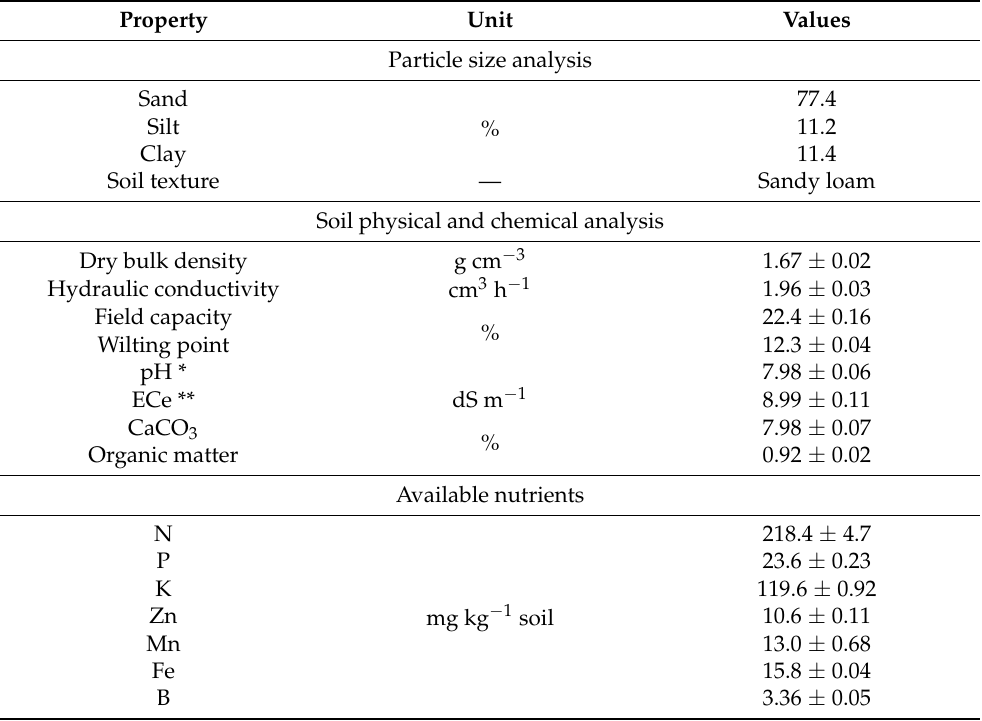
Table 1. Some properties of the tested soil (0–30 cm depth) before